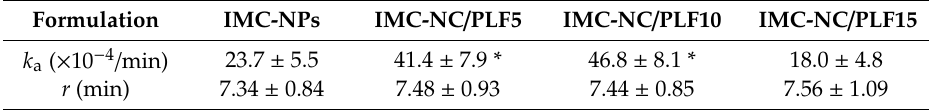
Figure 6. In vivo transcorneal penetration of each ophthalmic IMC-NC formulation. ( A ) Changes in IMC levels in rabbit LF instilled with each ophthalmic IMC-NC formulation. ( B ) Area under drug concentration–time curve between 0 and 90 min (AUC 0–90min ) in aqueous humor of rabbits instilled with each ophthalmic IMC-NC formulation. Compositions of each ophthalmic IMC-NC formulation shown in Table 1; n = 5–8; * p < 0.05 vs. IMC-NPs for each category. Introduction of 5% and 10% PLF-127 increased IMC transcorneal penetration in rabbits instilled with IMC-NC-incorporating ISG. In contrast to results for optimal PLF-127 (5% and 10%), excessive PLF-127 (15%) decreased IMC-NC uptake after instillation. Table 2. Pharmacokinetic parameters for the in vivo transcorneal penetration of each ophthalmic IMC-NC